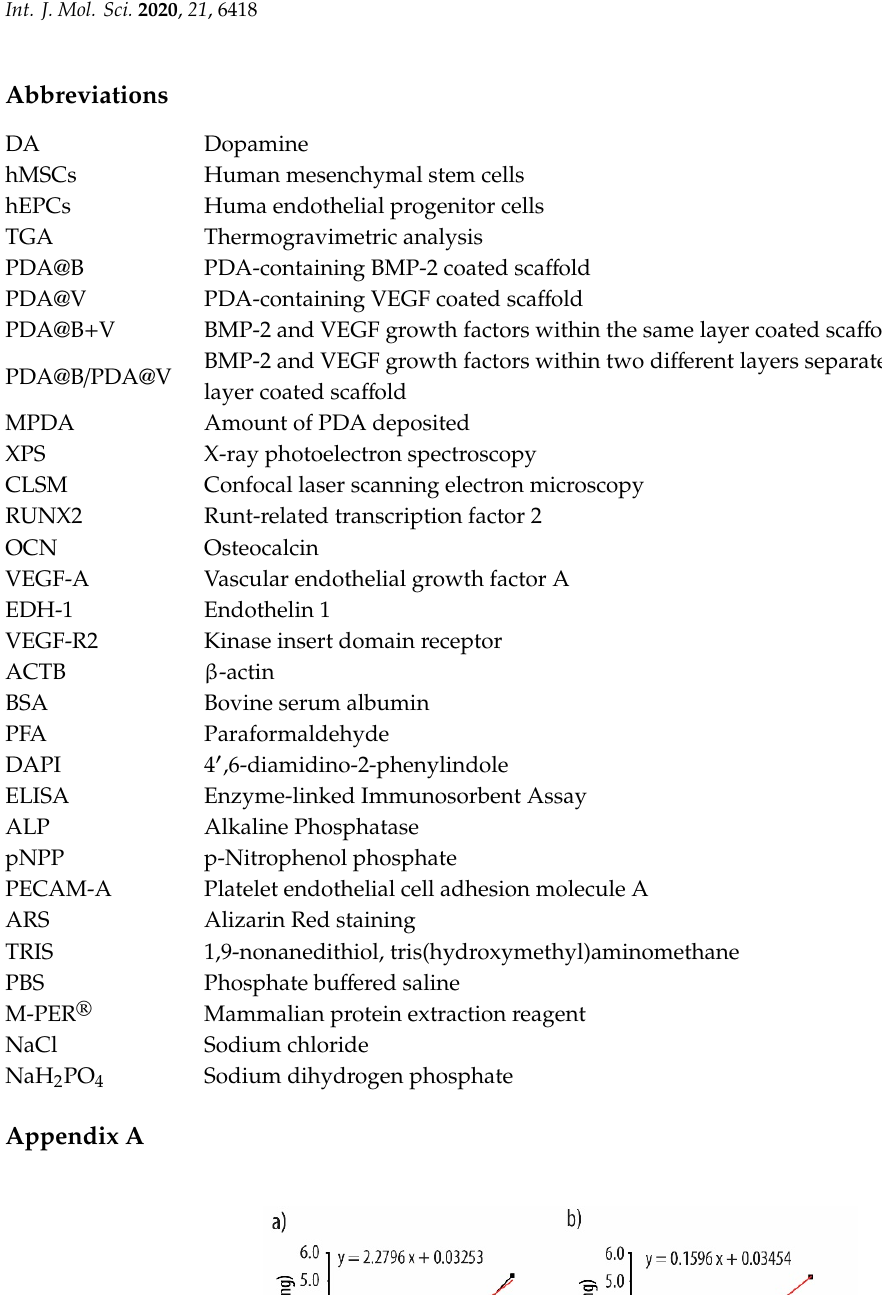
Figure A2. Surface chemical composition for the three different scaffolds as assessed by X-ray photoelectron spectroscopy. Bare scaffolds have been coated with polydopamine (PDA) only, PDA entrapping BMP-2 (PDA@B) and PDA entrapping both BMP-2 and VEGF growth factors (PDA@B/PDA@V).